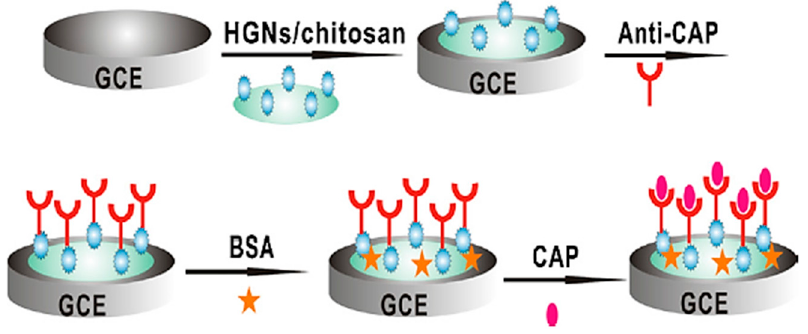
Figure 4. Schematic representation of the electrochemical immunosensor fabrication steps for the detection of chloramphenicol (reproduced from Zhang et al. [54] with permission).